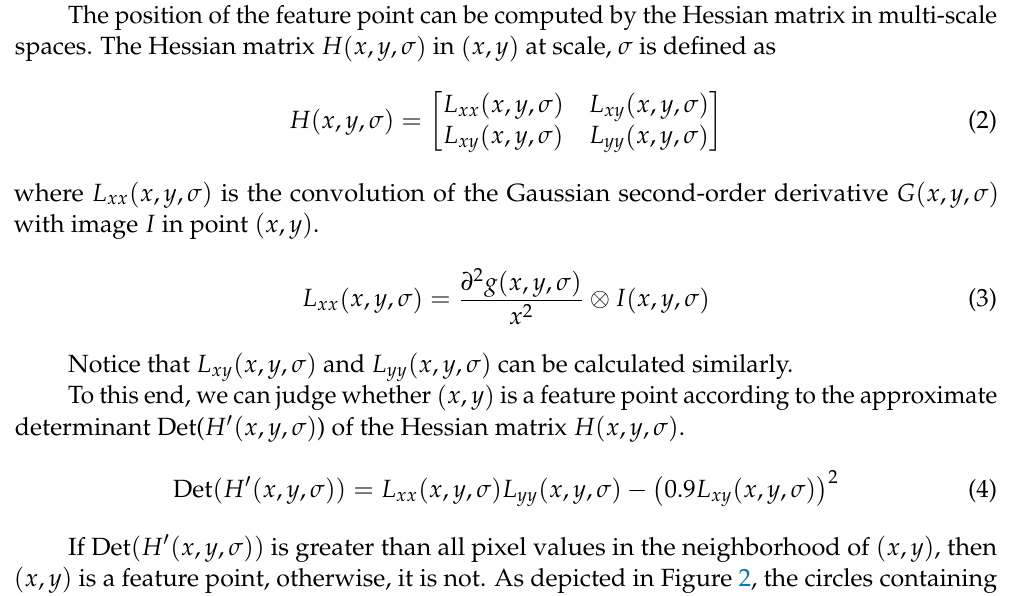
Figure 2. Flowchart of the SURF detector. The core idea of SURF consists of two steps: the first con- structs a multiple-scale space for each input image, then the second locates the feature-point posi- tion.